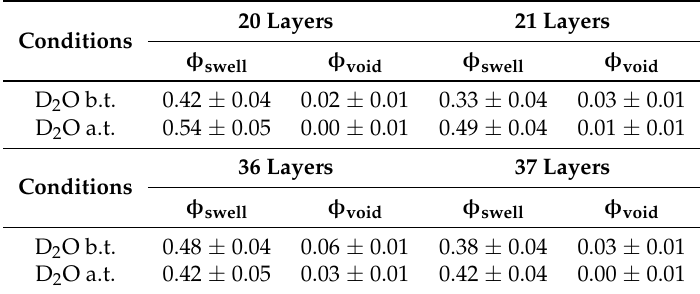
Table 2. The swelling water ( φ swell ) and void water ( φ void ) before (b.t.) and after (a.t.) thermal treatment, measured from d NR and SLD